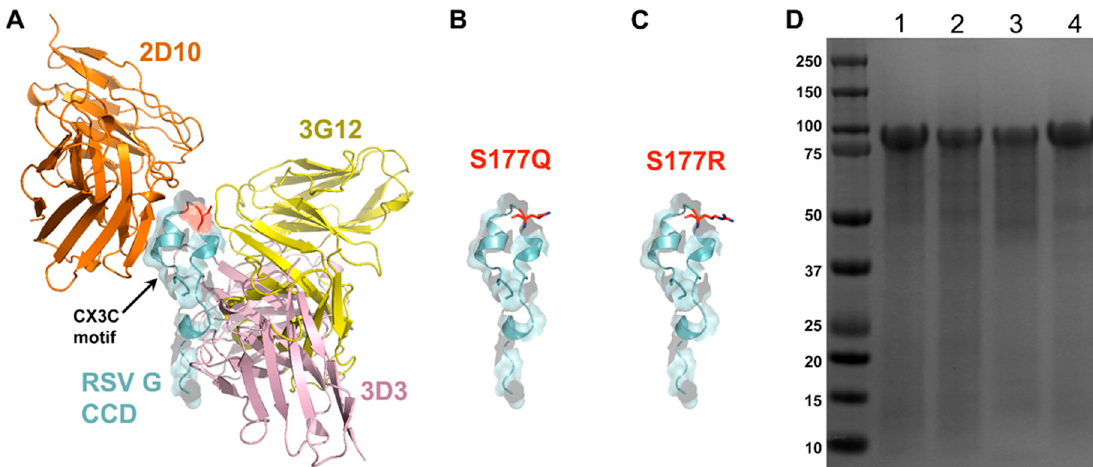
Figure 1. Rational design and expressiom of RSV G protein immunogens. ( A ) RSV G protein central conserved domain (CCD) (cyan) with CX3C motif highlighted, and sites of anti-G protein mAb binding: 2D10 (orange), 3G12 (yellow), and 3D3 (magenta). Serine 177 mutations modeled with ( B ) glutamine and ( C ) arginine. ( D ) Coomassie-stained SDS-PAGE gel of RSV G protein immunogens at ~90kDa. Lane 1: wild-type, lane 2: CX4C, lane 3: 177R, lane 4: 177Q.